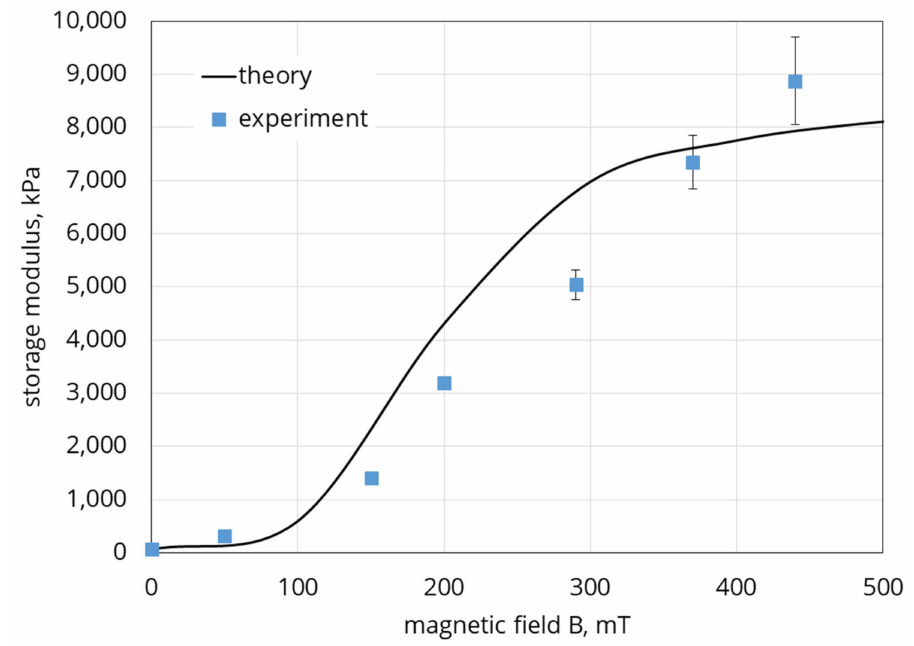
Figure 17. Shear modulus vs. the applied magnetic field. System parameters: χ 0 = 300, G 0 = 10 kPa, in Figure 7. Volume concentration of the embedded particles is